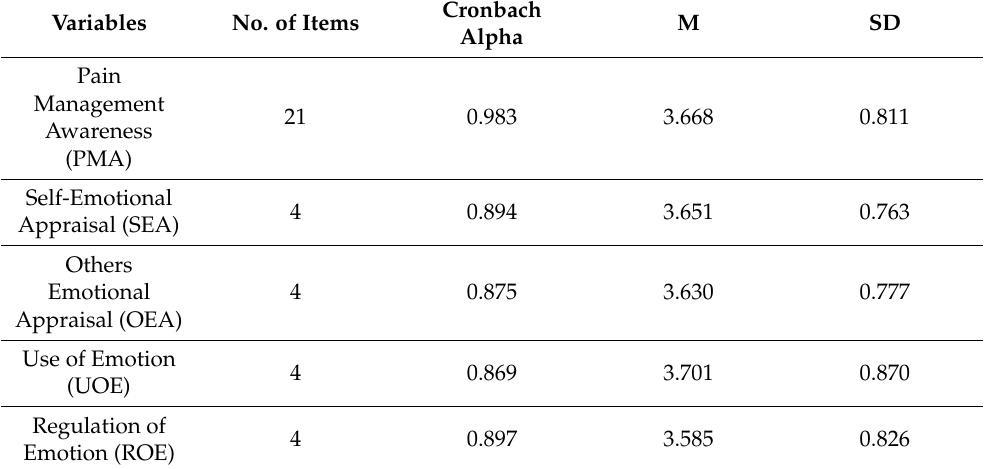
Table 2. Reliability